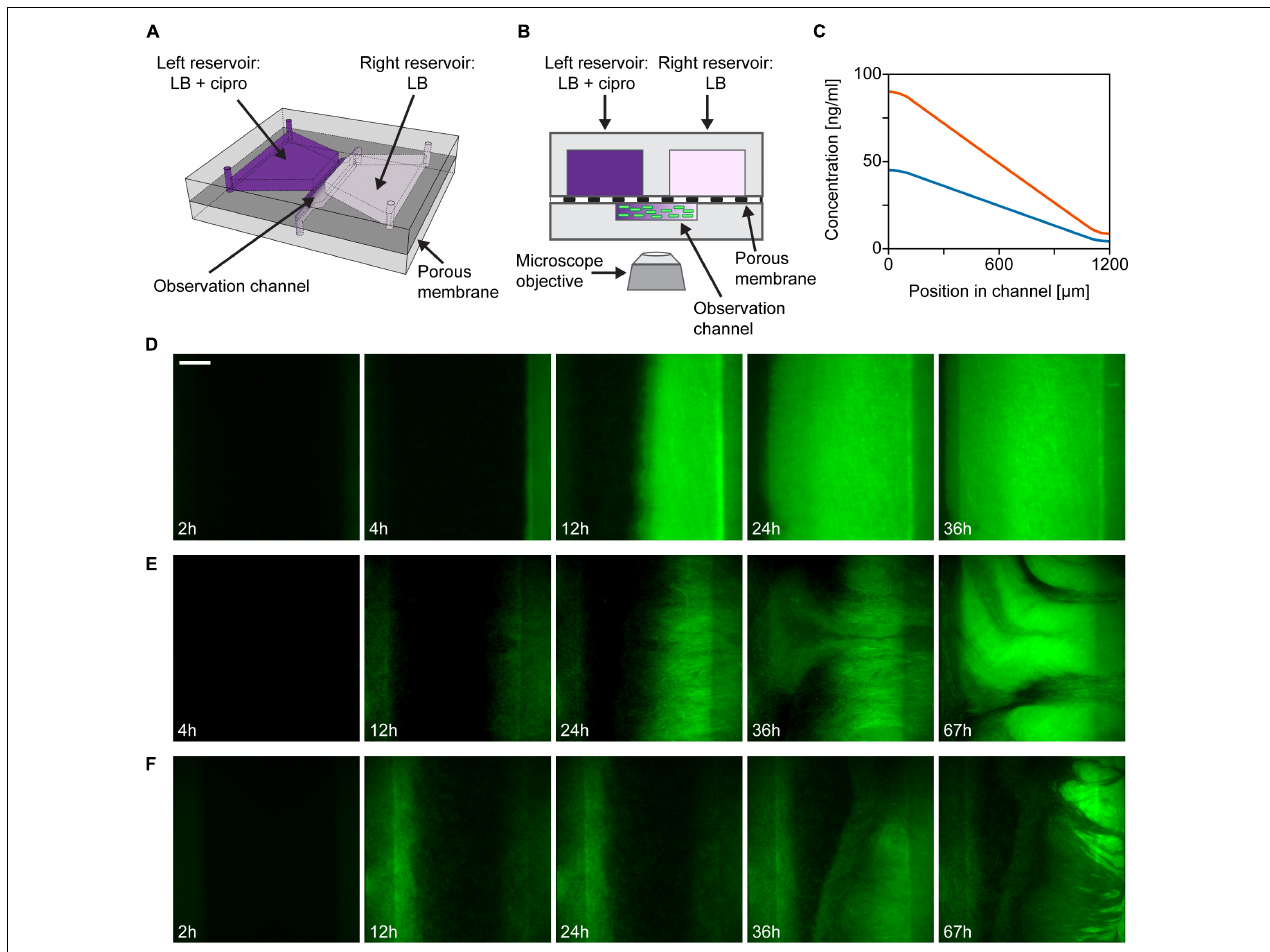
FIGURE 1 | Outline of the gradient generator microfluidic setup and time-lapse images of a growing bacterial population within. (A) Schematic drawing of the microfluidic gradient generator device (not-to-scale). (B) Illustration of the cross-sectional view of the device (not-to-scale). (C) Theoretical profiles of ciprofloxacin concentration across the width of the observation channel in case of loading 48 ng/ml (3 × MIC, blue curve) or 96 ng/ml (6 × MIC, orange curve) antibiotic solution into the left reservoir. (D–F) Fluorescent images showing the distribution of bacteria across the observation channel (scale bar is 200 µ m). Maximum ciprofloxacin concentrations (left side) are as follows: (D) 3 × MIC; (E) 3 × MIC; and (F) 6 ×